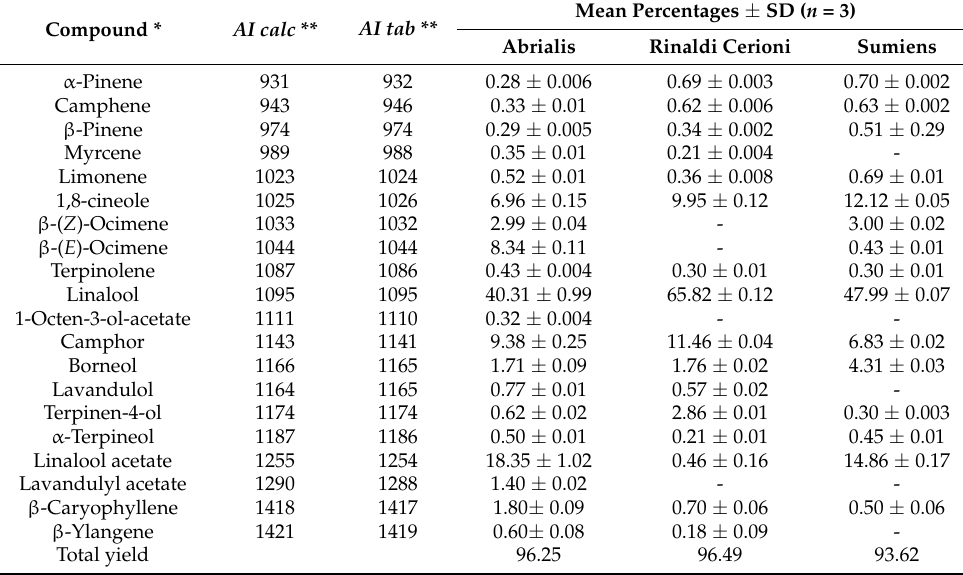
Table 1. Chemical composition of EOs from lavandin cv Abrialis, Rinaldi Cerioni, and Sumiens as determined by GC-FID and GC-MS